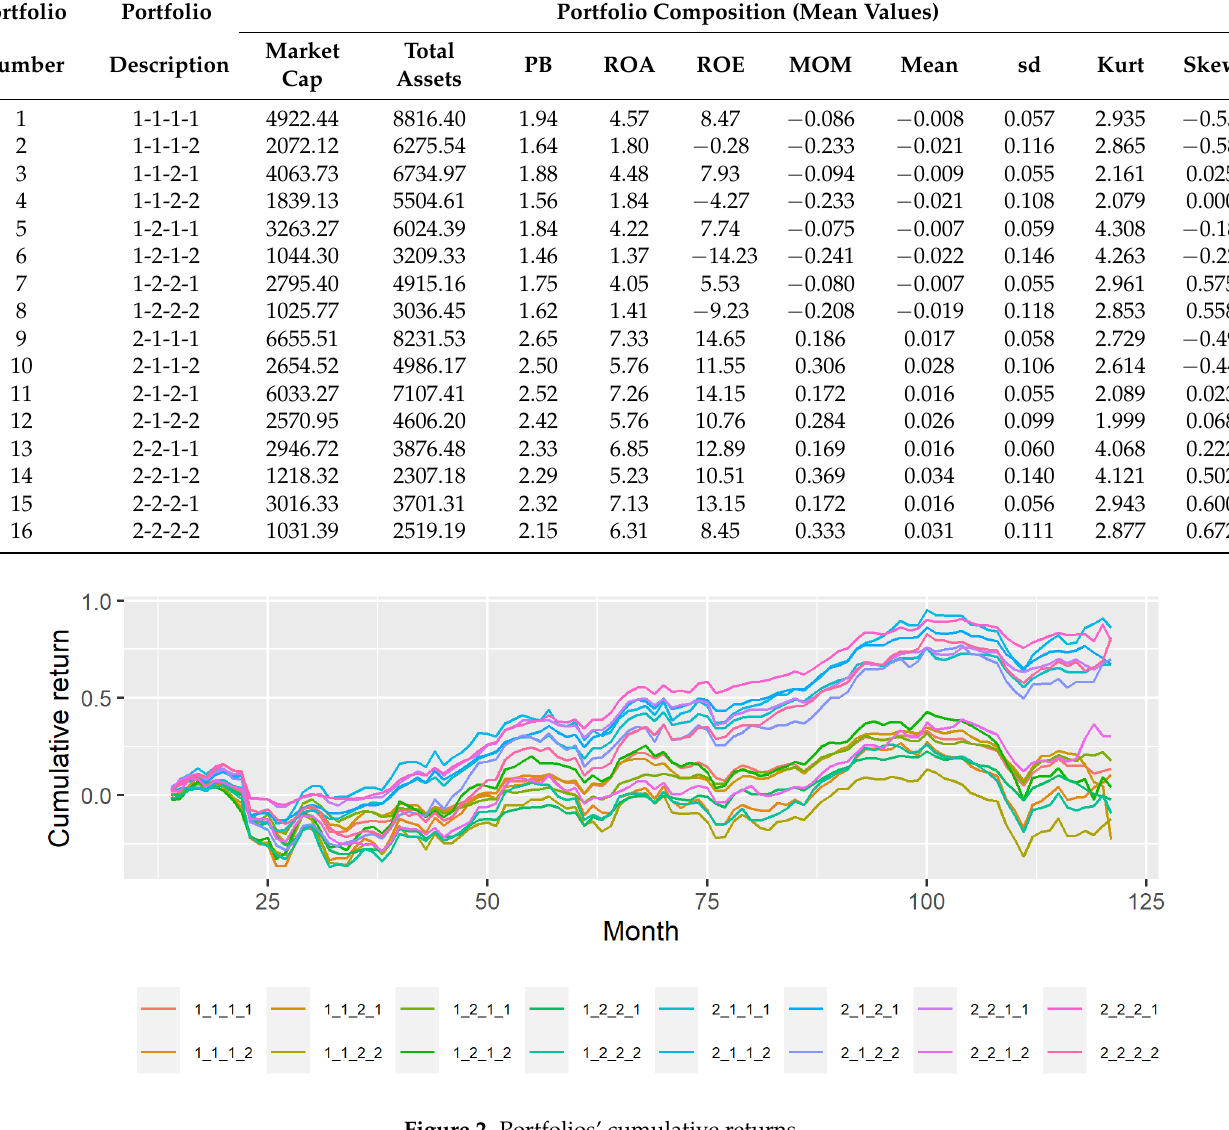
Figure 2. Portfolios’ cumulative